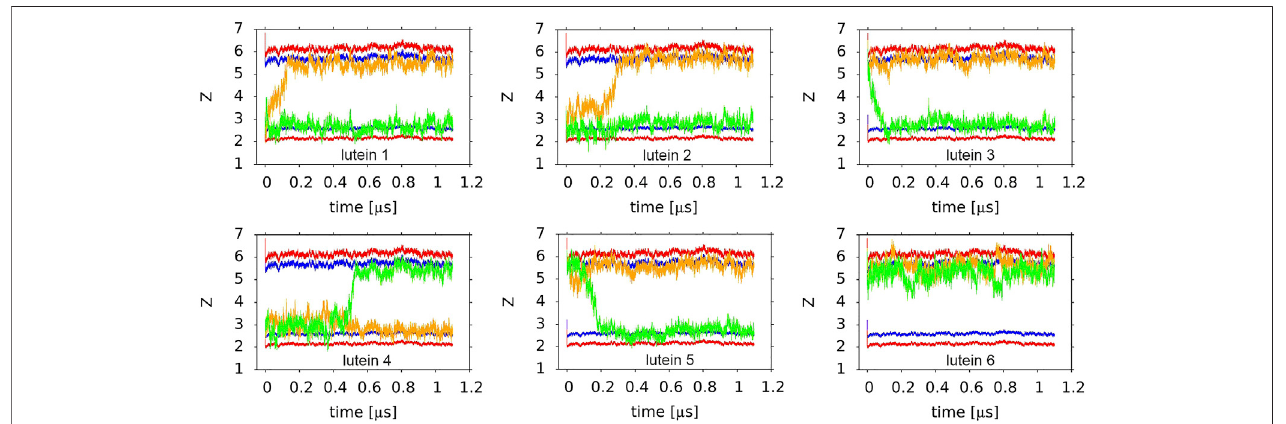
FIGURE 7 | Time pro fi les of the orientations of six lutein molecules in the PC-LUT_H bilayer. The orange and green lines show the trajectories of the centre-of- massesofthe ß ( orange )and ε ( green )ringsalongthe z -axis.Twohorizontal red and blue linesindicatetheaverageverticallocationofthePOPCPandglycerolOatomsin each of the bilayer lea fl ets. The order of the plots corresponds to the lutein molecule numbering (#4 is the fi rst and #6 is the last in the lower